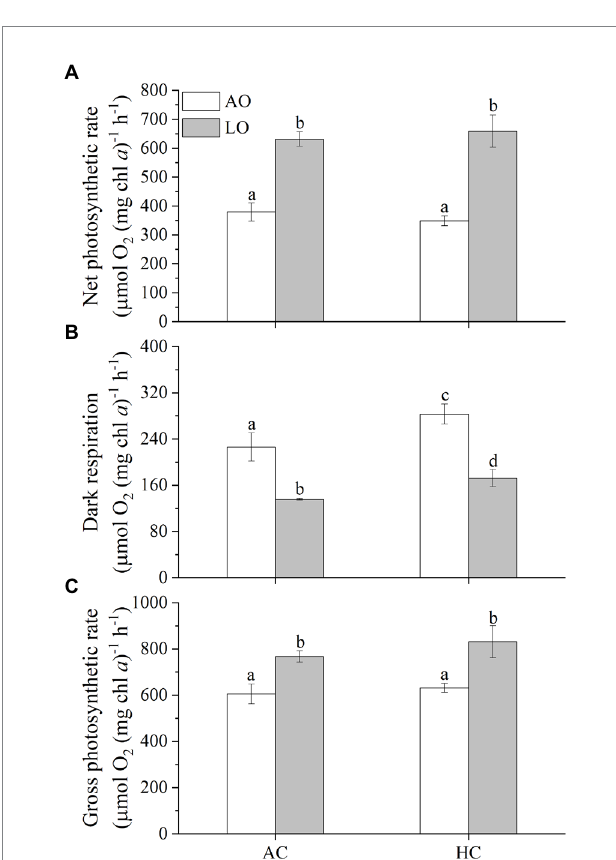
FIGURE 2 The rates of net photosynthetic O 2 evolution (A) , dark respiration (B) and gross photosynthetic O 2 evolution (C) in T . erythraeum IMS101 cells after acclimated different levels of p CO 2 and p O 2 (as shown in Figure 1) for 28–30 days (21–23 generations). Levels of p CO 2 and p O 2 are the same or within the same ranges as shown in Figure 1. The values are indicated as the means ± SD for triplicate cultures at each treatment. Different letters above the bars indicate significant ( p < 0.05) differences among the